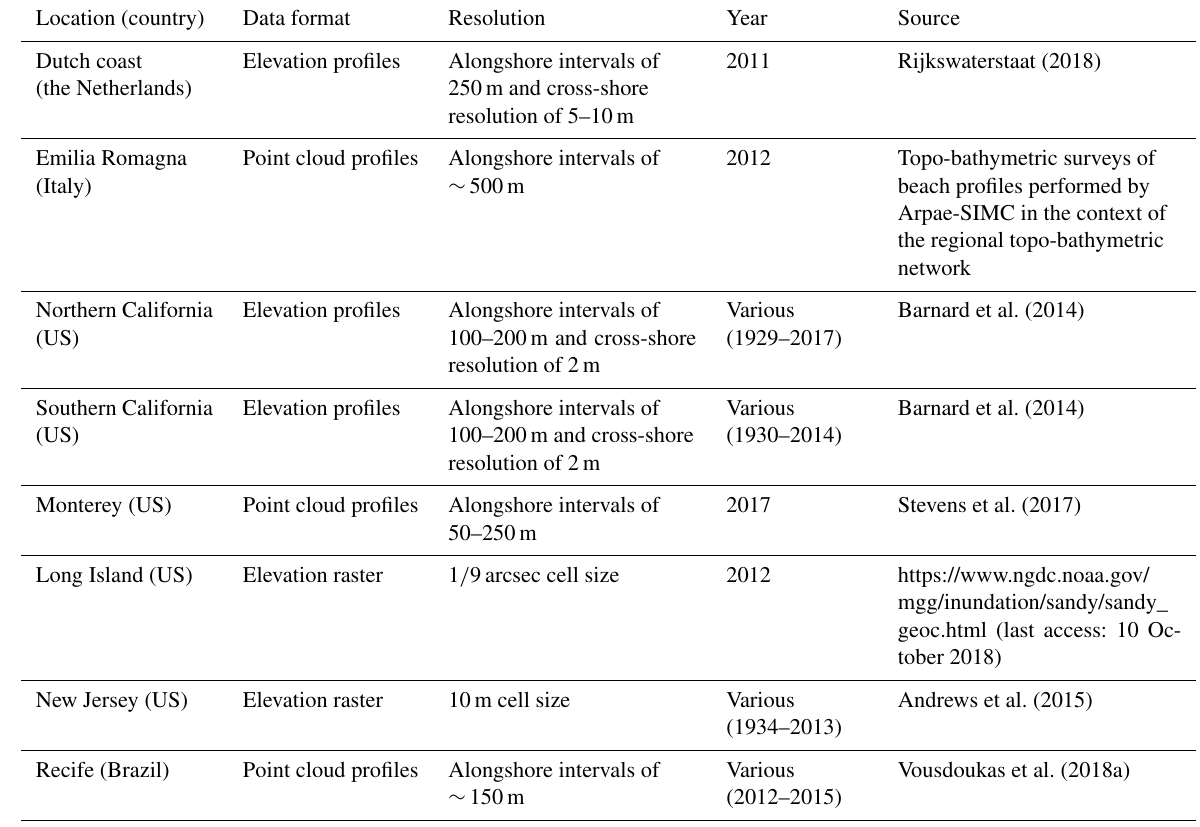
Table 1. Validation case study descriptions.